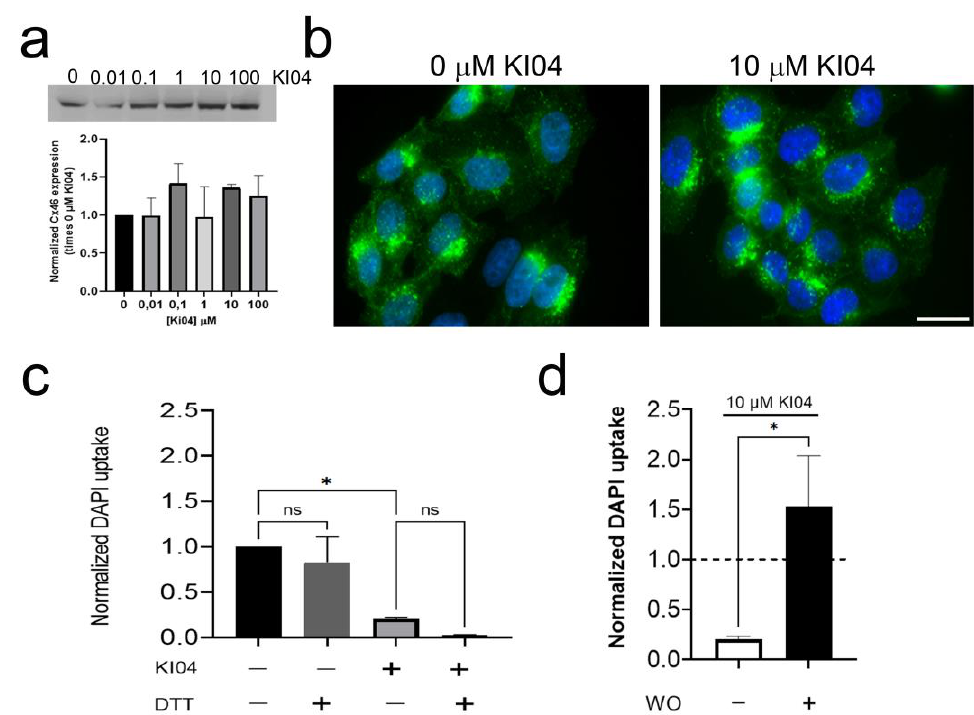
Figure 3. KI04 does not induce changes in Cx46 molecular weight and cellular distribution. ( a ) Western blot analyses show that none of the KI04 concentrations used in this study (from 0.01 to 100 μ M) induced changes in Cx46 electrophoretic mobility. Similarly, ( b ) 10 µ M KI04 did not induce evident changes in Cx46 intracellular localization. ( c ). Addition of 5 mM DTT shows a tendency to reduce the rate of DAPI uptake, and moreover, it did not reverse the inhibition mediated by KI04. ( d ) On the contrary, for Cx46tGFP cells that were transiently exposed to 10 μ M KI04, the inhibitory effect was completely reversed, and moreover, there was an increase in DAPI uptake ( n = 4 for each experiment, 16 cells analyzed in each case). For each experiment, DAPI fluorescence intensity was measured in 16 cells. p < 0.05 = * and no statistical differences ( p > 0.05), was denoted as ns.